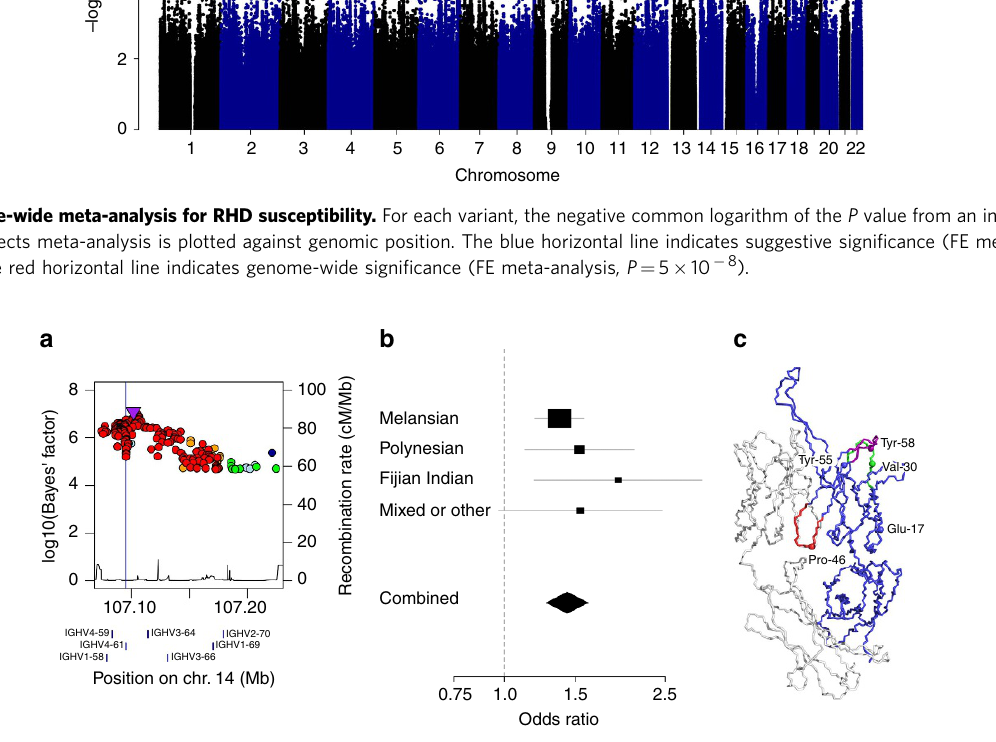
Figure 3 | Association of the IGHV4-61 locus with RHD susceptibility. ( a ) For each variant in the 99% credible set, the common logarithm of the Bayes’ factor is plotted against genomic position. Variants are coloured by linkage disequilibrium with the most associated variant averaged across the entire data set (estimated r 2 : dark blue, 0–0.2; light blue, 0.2–0.4; green, 0.4–0.6; yellow, 0.6–0.8; red, 0.8–1.0). A vertical blue line indicates the position of the four nonsynonymous variants in IGHV4-61 and locations of expressed IGH gene segments are indicated by blue rectangles below the x axis. ( b ) Forest plot for the IGHV4-61 *02 allele under an additive genetic model with association statistics from LMM analysis in each strata combined by FE meta-analysis. Individual and combined odds ratio estimates with confidence intervals are shown on a logarithmic scale. ( c ) Structural model of an antibody that includes the IGHV4-61 heavy variable domain (Protein Databank 4FQQ) showing both heavy (blue) and light (white) chains with both the first (CDR-H1, green) and second (CDR-H2, violet) heavy chain complementarity determining loops and the heavy chain interface framework loop (HIFL, red) highlighted. The positions that distinguish IGHV4-61 *01 from IGHV4-61 *02 are shown as spheres labelled with the amino acids found in IGHV4-61